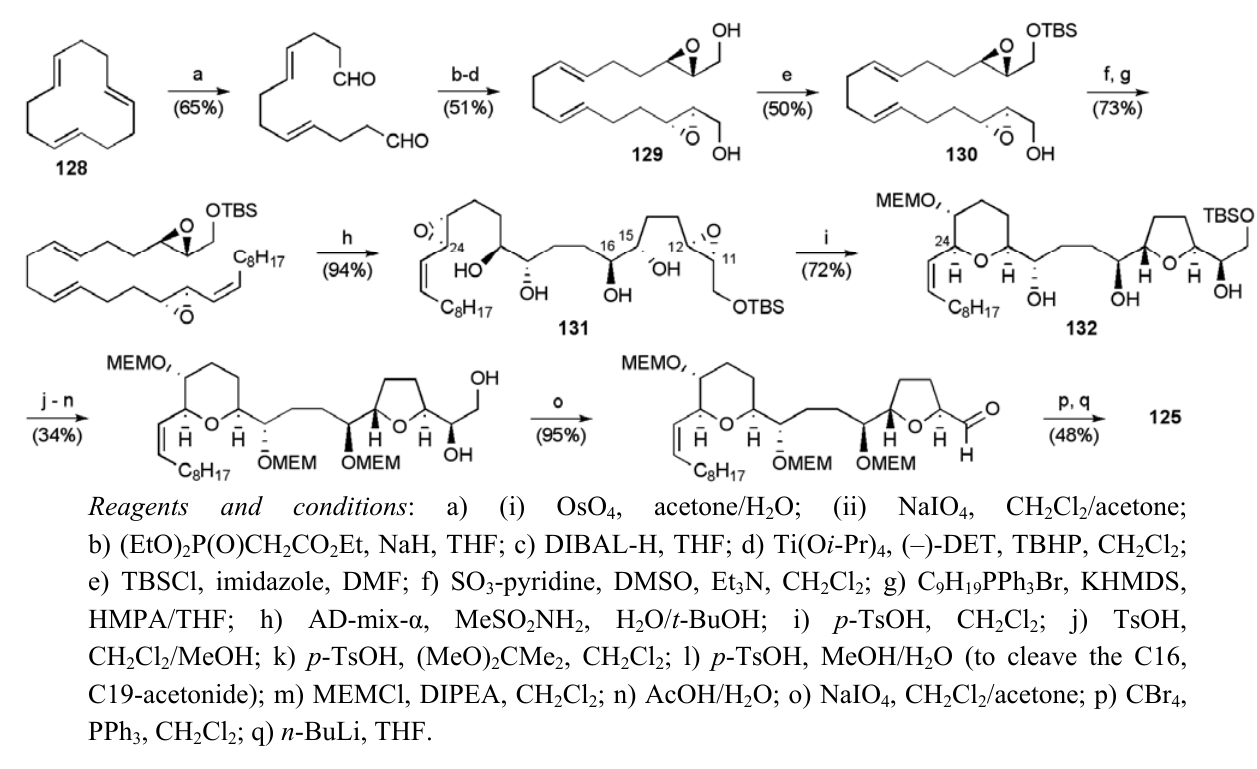
Scheme 31. Synthesis of alkyne 125